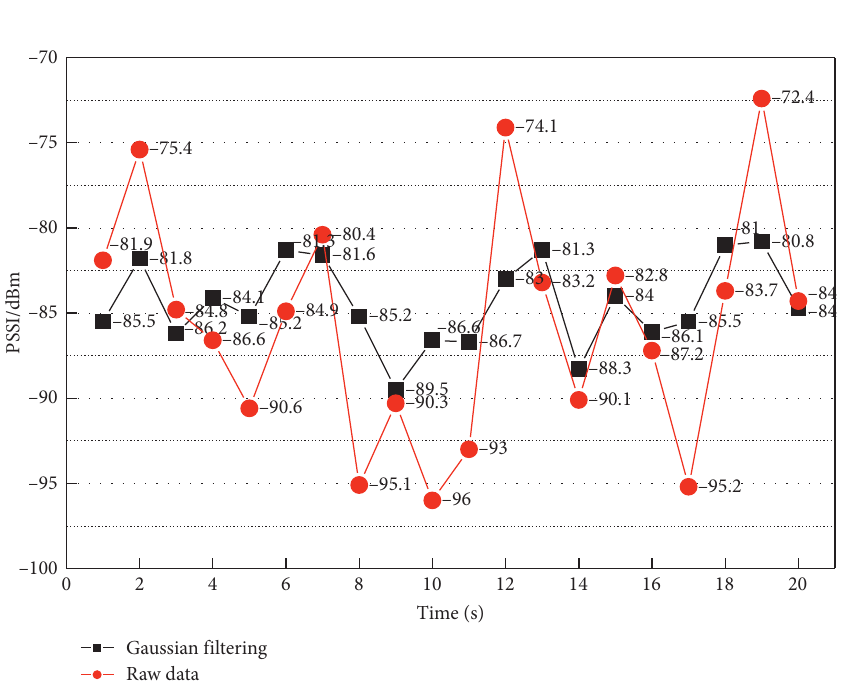
Figure 7: Data acquisition